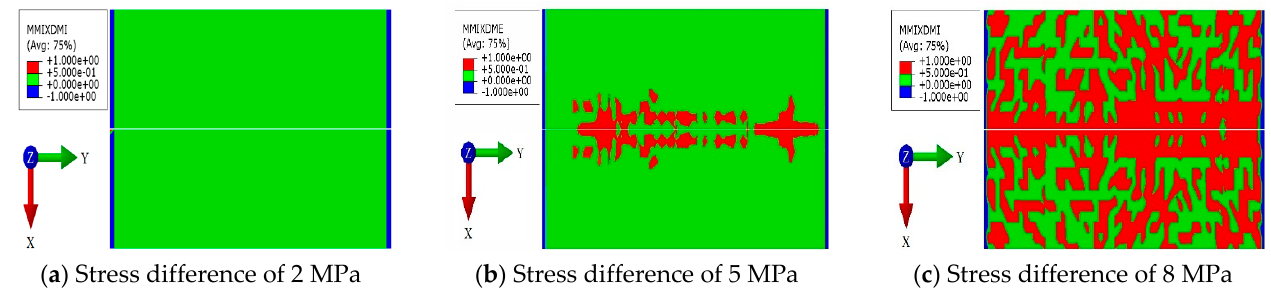
Figure 9. Fracture morphology at the deflagration point under variable stress differences.